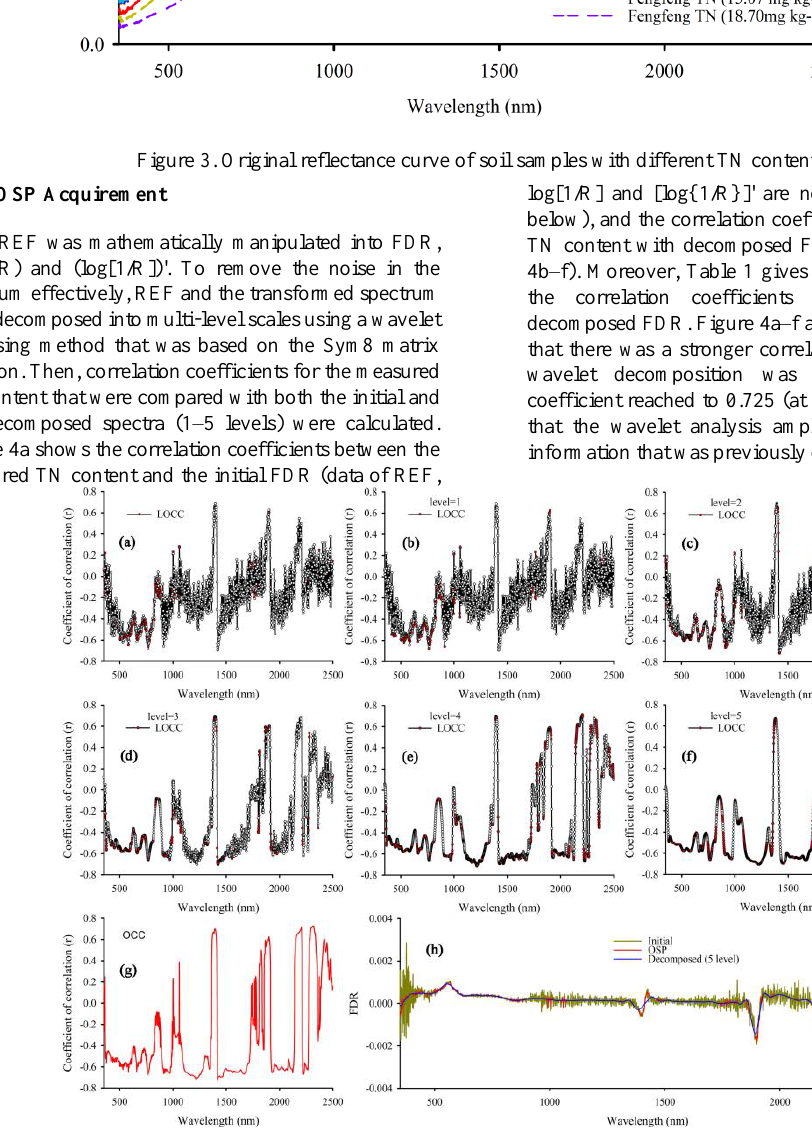
Figure 4. Wavelength dependence of coefficients of correlation between total soil nitrogen (TN) and first derivative differential of the soil spectra: initial (a); decomposed (1–5 levels) (b–f); optimal correlative curve (OCC) (g), and (h) first derivative differential reflectance curve of soil sample (Initial, decomposed [5 level] and the optimal spectra